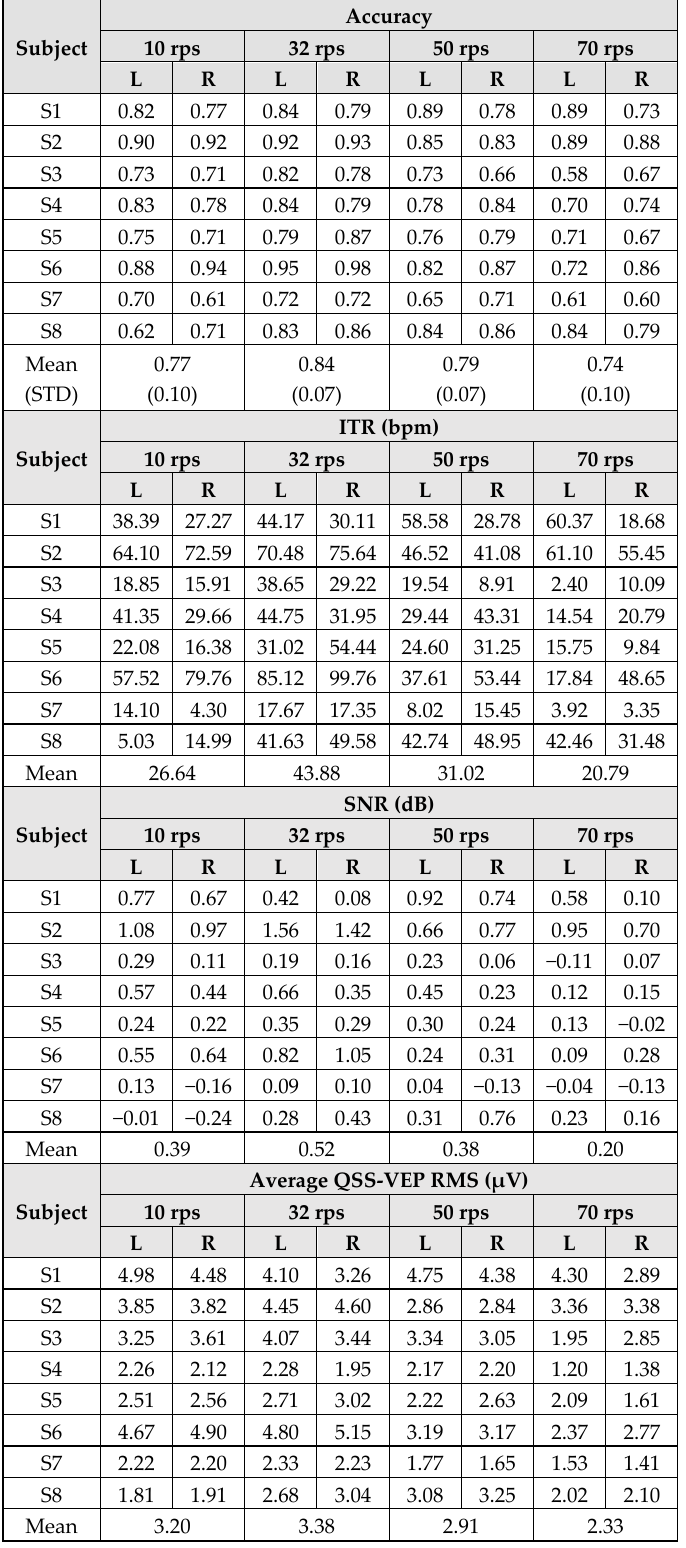
Table 2. Single sweep (0.5 s) quasi-steady-state-visual evoked potentials (QSS-VEP) accuracy, information transfer rates (ITR), mean signal to noise ratio (SNR), and root mean square (RMS) overall average values for all rates and eight subjects (S1–S8).